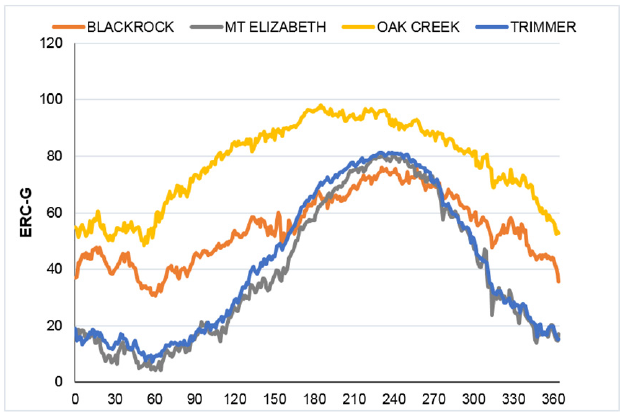
Figure 5. ERC ‐ G by Julian day for each of the four RAWS locations used in fire modeling. Figure 5. ERC-G by Julian day for each of the four RAWS locations used in fire